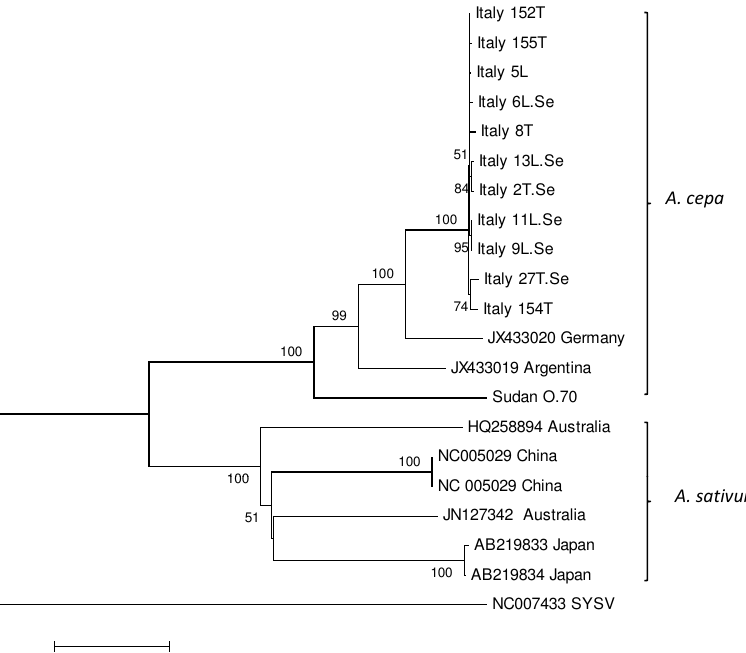
Figure 2. Neighbour-joining tree based on multiple alignment of partial nucleotide sequences, including partial NIa-Pro, complete NIb and CP genes and 3’UTR, of OYDV between Italian and Sudanese isolates from this study, German and Argentine isolates from onion and isolates from garlic available from the database. The sequence of SYSV (NC007433) was used as an out-group. Bootstrap percentages of clades, reported along the branches of the tree with value >50%, derived from bootstrap-resampled data sets (1000